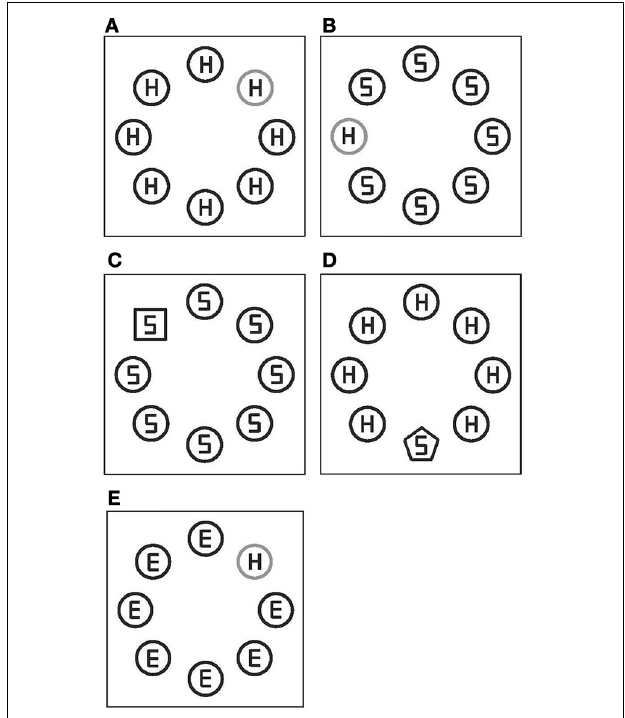
FIGURE 1 | Examples of stimulus displays in Experiment 1. (A) Yellowish-red target, (B) yellowish-green target, (C) square target, (D) pentagon target, and (E) yellowish-red target, for response congruent trials (A,C) , for response incongruent trials (B,D) , and for neutral trials (E) . All the stimuli were yellow on black background, except for the yellowish-red and yellowish-green target (depicted in